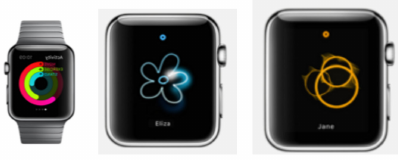
Figure 1. Health App by Apple.